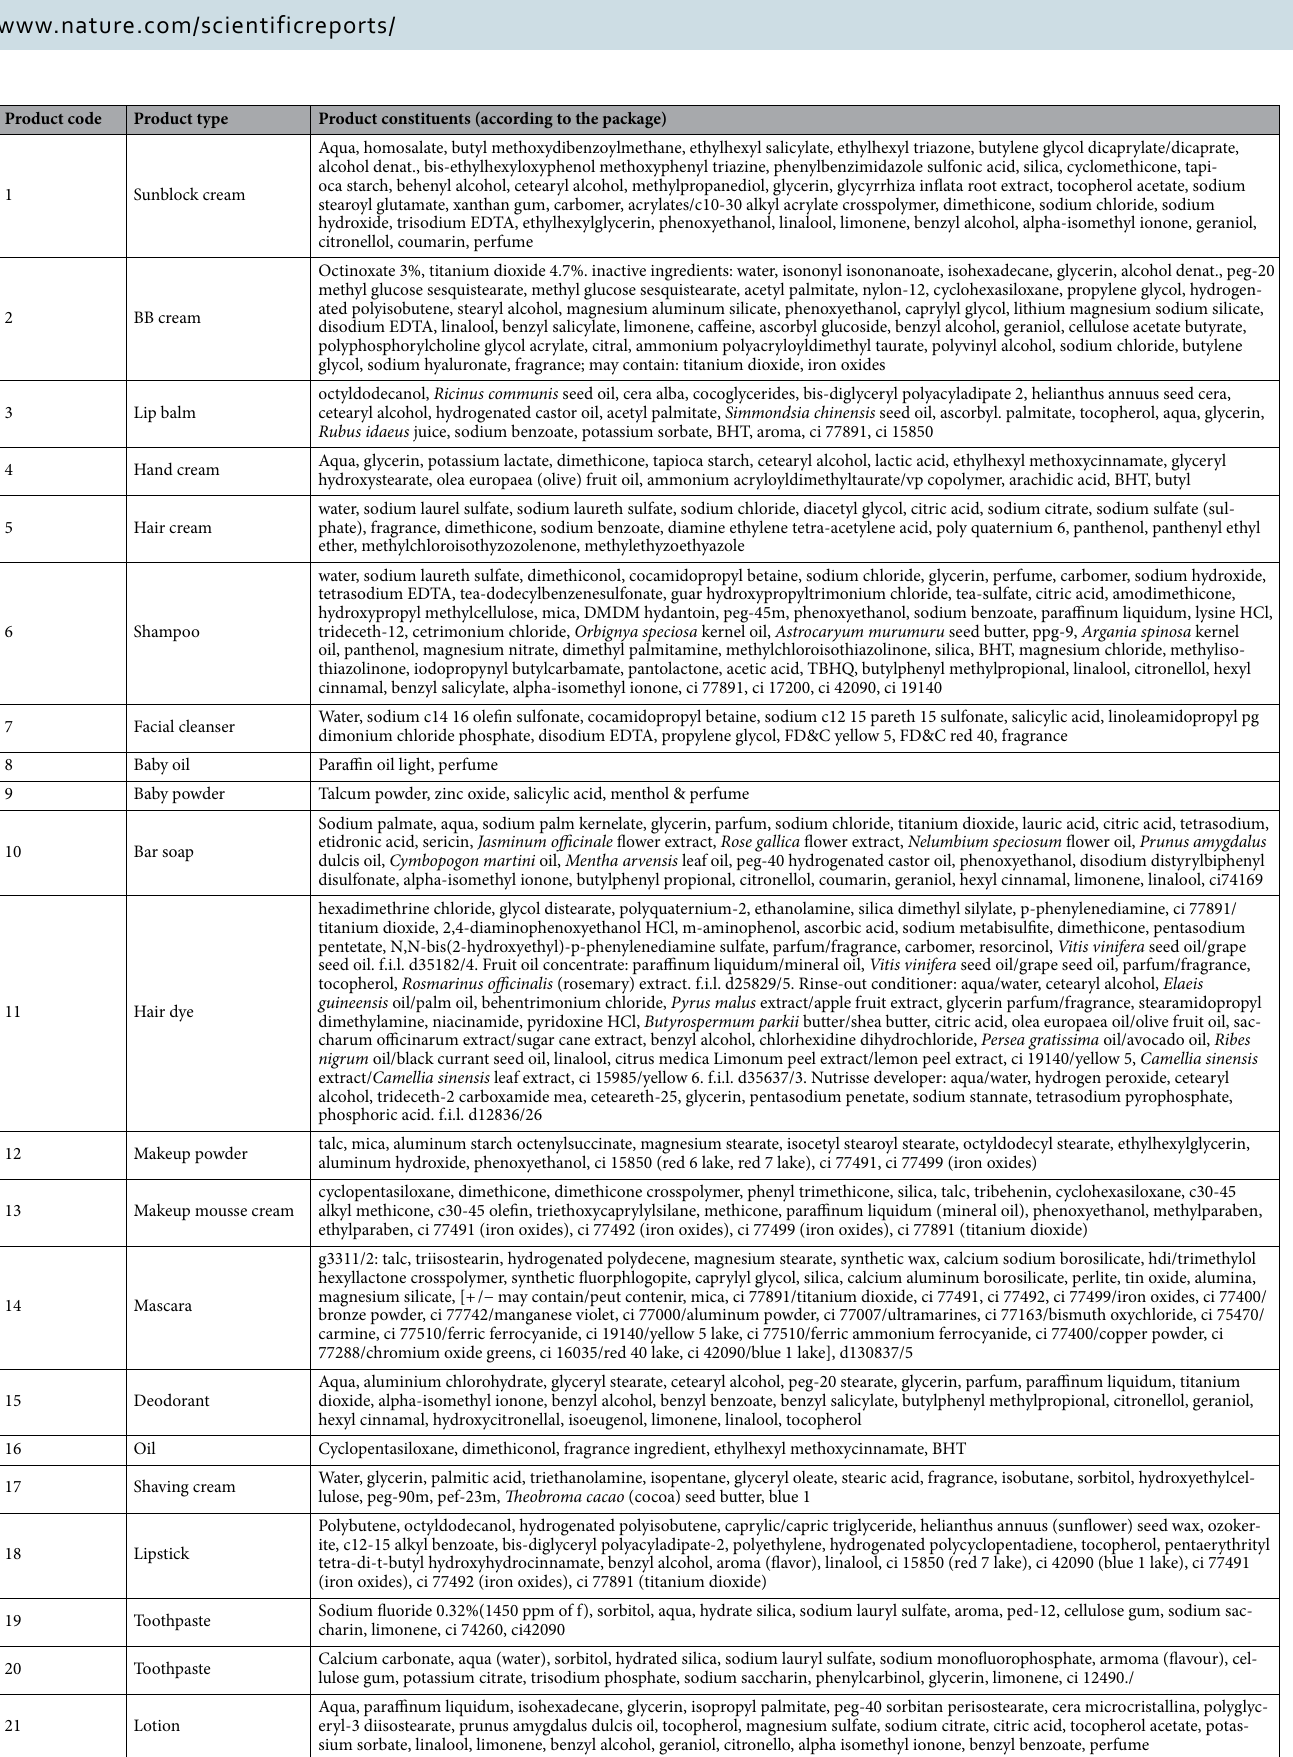
Table 1. Topical cosmetic products used in the